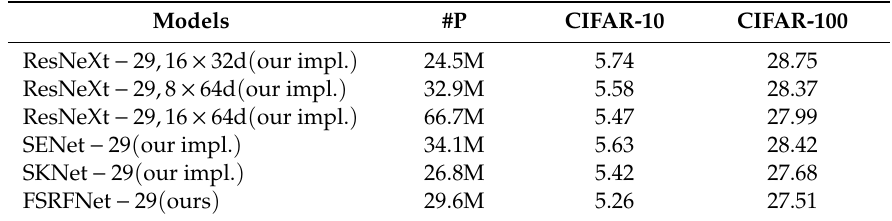
Table 6. Top-1 errors (%) on CIFAR, with SENet-29, SKNet-29, and FSRFNet-29 all based on ResNeXt-29, 16 × 32d.